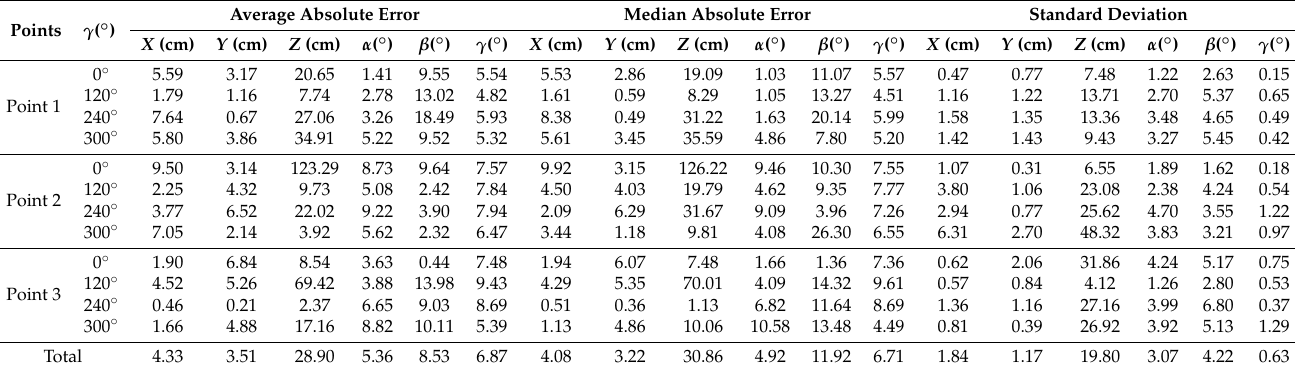
each point. The obtained results for coordinates x , y and z are 4.33 cm, 3.51 cm and 28.90 cm for the total average absolute error and 1.84 cm, 1.17 cm and 19.80 cm for the standard deviation, respectively. In addition, the obtained results for the rotation angles α , β and γ are 5.36 ◦ , 8.53 ◦ and 6.87 ◦ for the total average absolute error and 3.07 ◦ , 4.22 ◦ and 0.63 ◦ for the standard deviation, respectively. It is worth mentioning that points beyond 3 σ are treated as outliers and are not taken into consideration in the analysis. Note that 3 σ includes the 99.73 % of all the data. Table 2. Experimental average, median and standard deviation of the absolute error for the three analysed points with γ = {0 ◦ , 120 ◦ , 210 ◦ and 300 ◦ } using the IPPE algorithm. Average Absolute Error Median Absolute Error Standard Deviation Points γ ( ◦ )